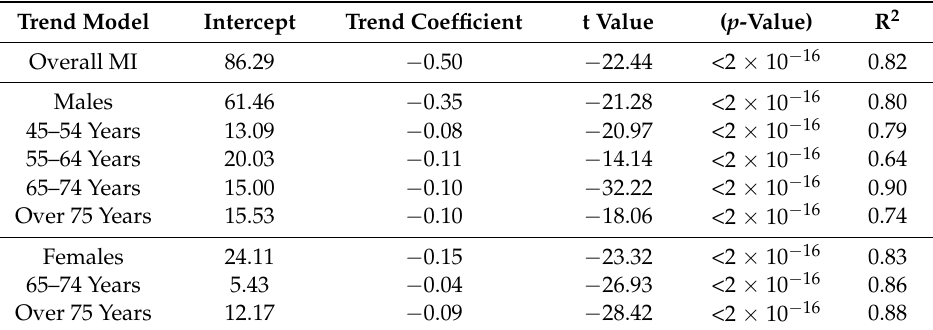
Table 1. Linear trend model for age-gender specific MI hospitalization rates.